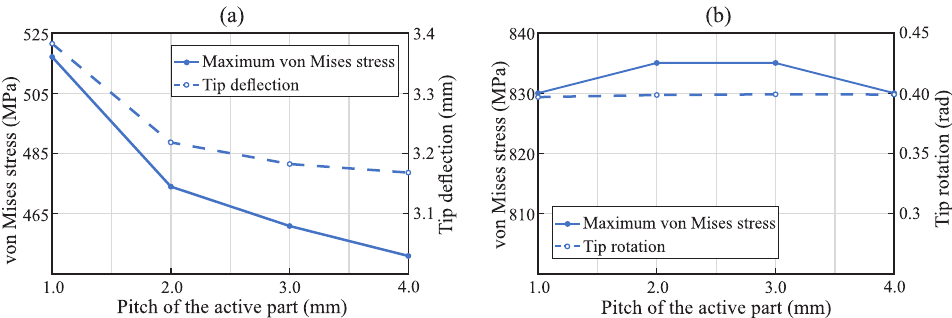
Figure 11. Results of the parametric study of the pitch of the active part: ( a ) bending analysis and ( b ) torsional analysis.